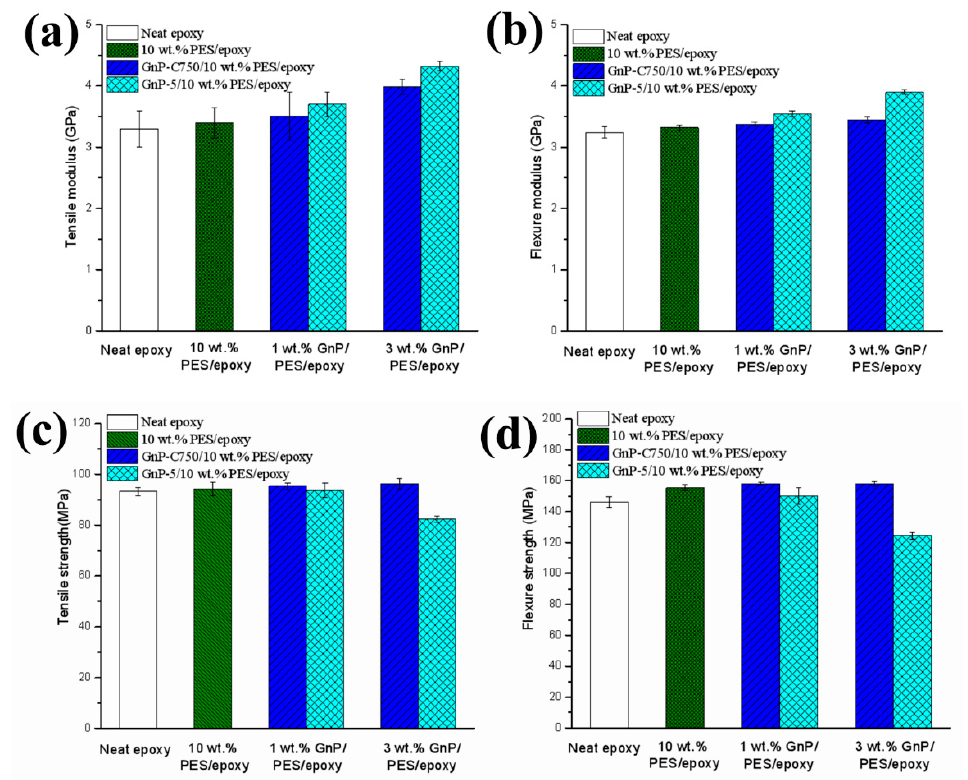
Figure 6. ( a ) Tensile modulus, ( b ) flexural modulus, ( c ) tensile strength, and ( d ) flexural strength of epoxy-based composites.